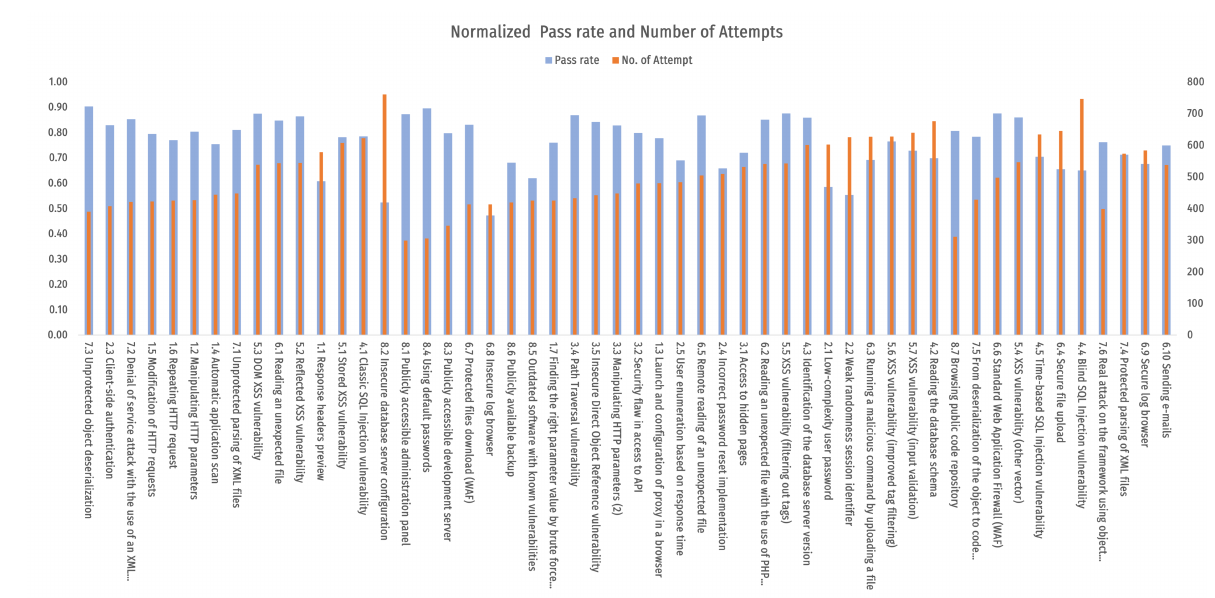
Figure 14. Normalized pass rate and number of